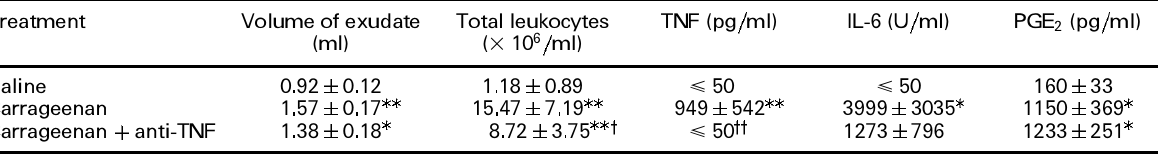
Table 3. Effect of anti-TNF antibodies on the in¯ ammation induced by carrageenan in the mouse air pouch